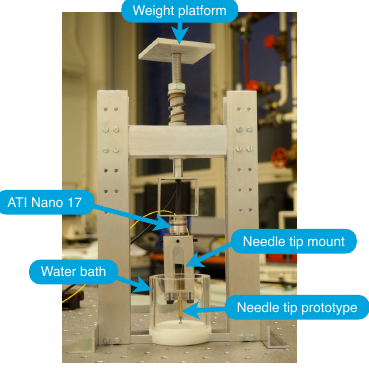
Figure 7. Calibration setup used to test prototypes of the needle tip containing an FPI-based force